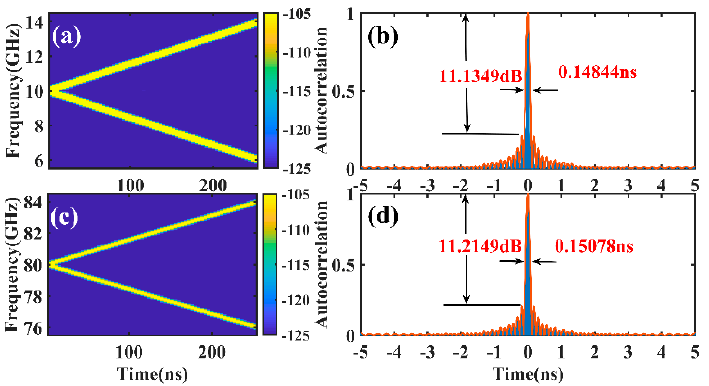
Figure 7. Time-frequency diagram and autocorrelations of the separate dual-chirp signal with frequency of 10 GHz ( a , b ) and 80 GHz ( c , d ).